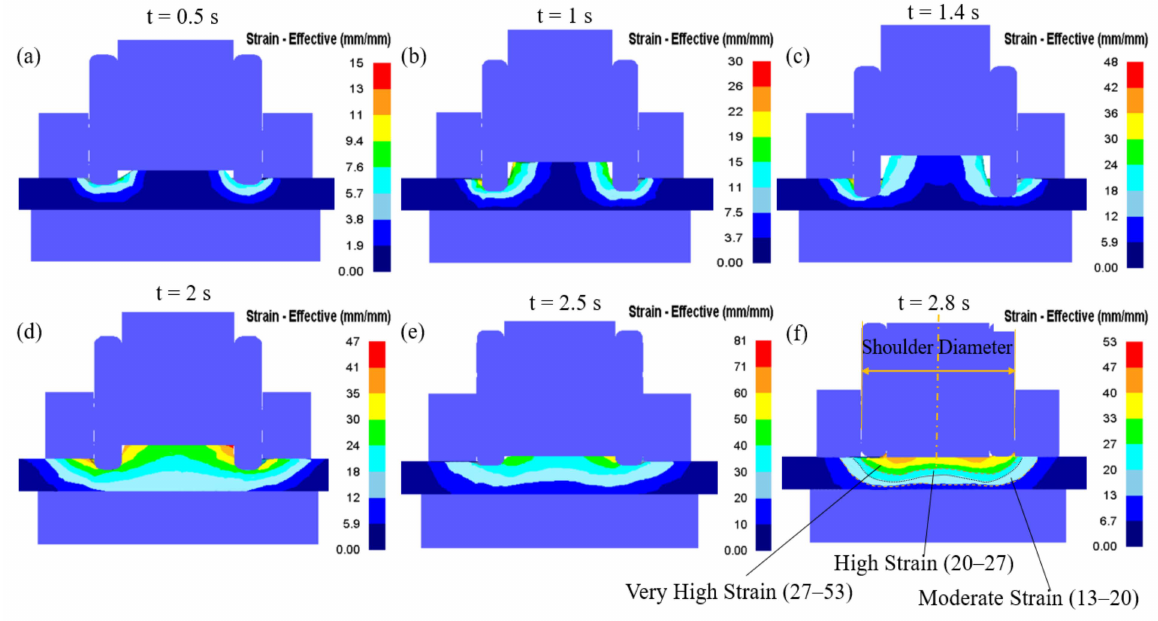
Figure 9. Strain (effective) distribution during the plunging ( a – c ) and refilling ( d – f ) stages. ( a ) 0.5 s; ( b ) 1 s; ( c ) 1.4 s; ( d ) 2 s; ( e ) 2.5 s; ( f ) 2.8